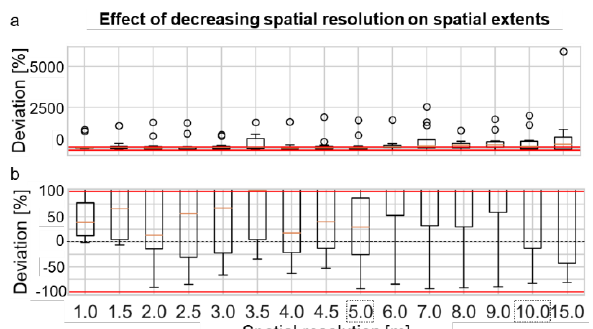
Figure 6. Deviation of spatial extent delineated by region growing for decreasing spatial resolution compared to the reference objects obtained at highest input data resolutions (0.5 m). (a) Full range of deviations, and (b) close-up to bounds of 100 %. Boxes on x-axis labels mark changes in the reduction